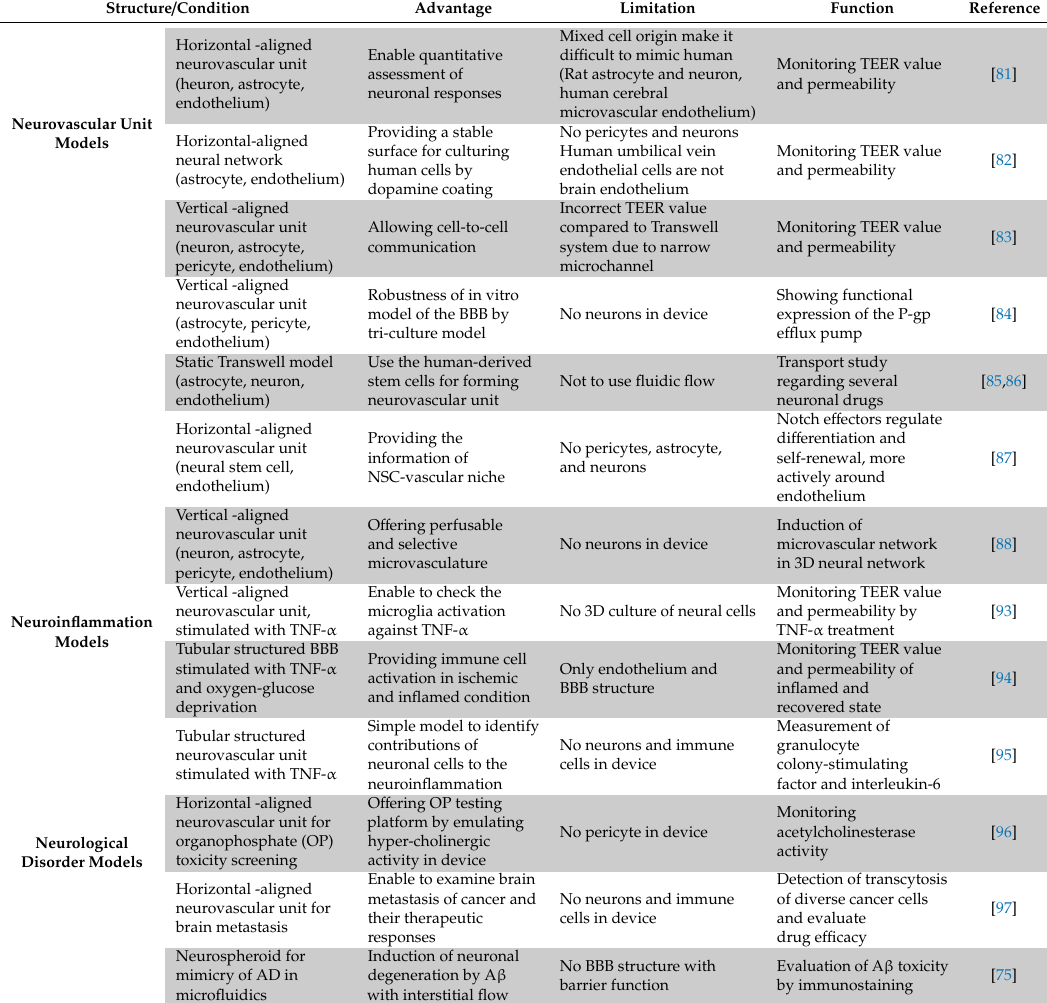
Table 3. Advantages and limitations of in vitro neurovascular unit and disorder